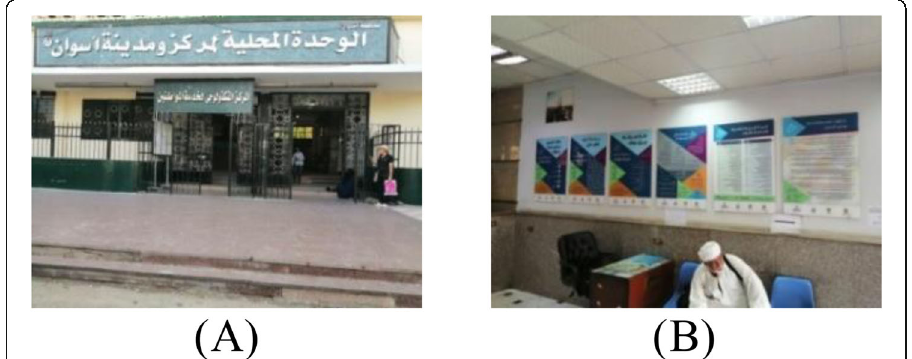
Fig. 4 The entrance and the signage in the first section of the building,